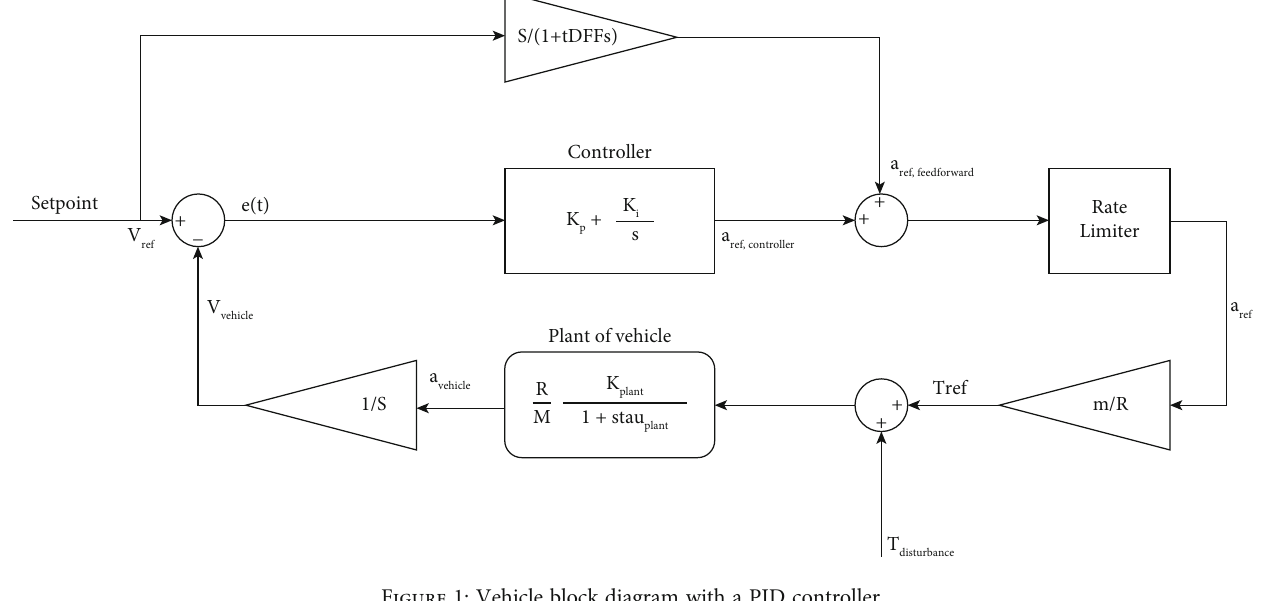
Figure 1: Vehicle block diagram with a PID controller. Table 1: Block diagram